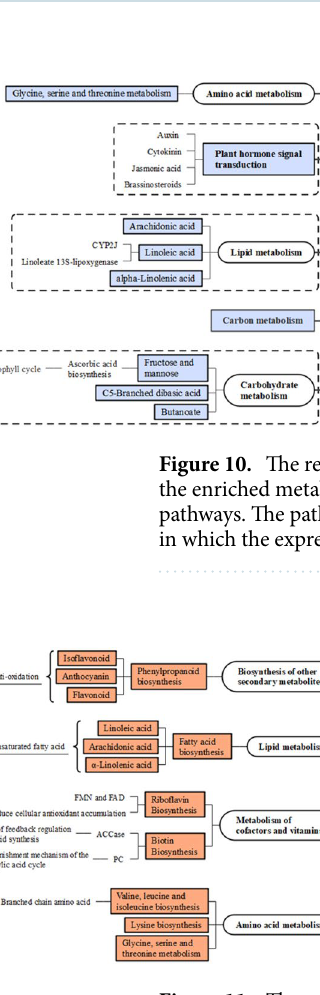
phate (SBP) into sedum heptulose-7-phosphate (S7P) in the renewal phase. Under low-temperature stress, only